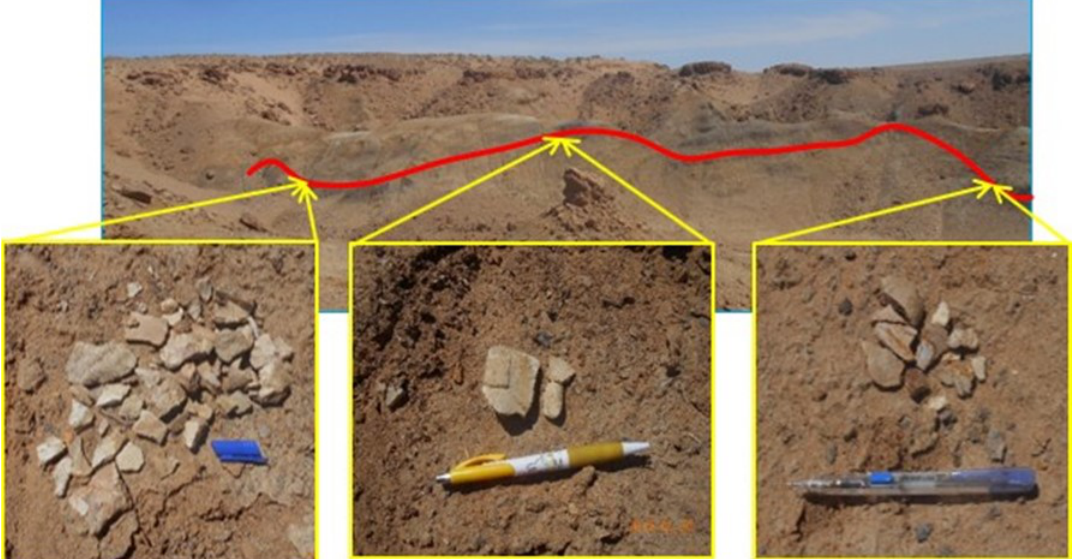
Fig. 11. Location of turtle fossils, Northwestern part of the Ergel-Khaliv section